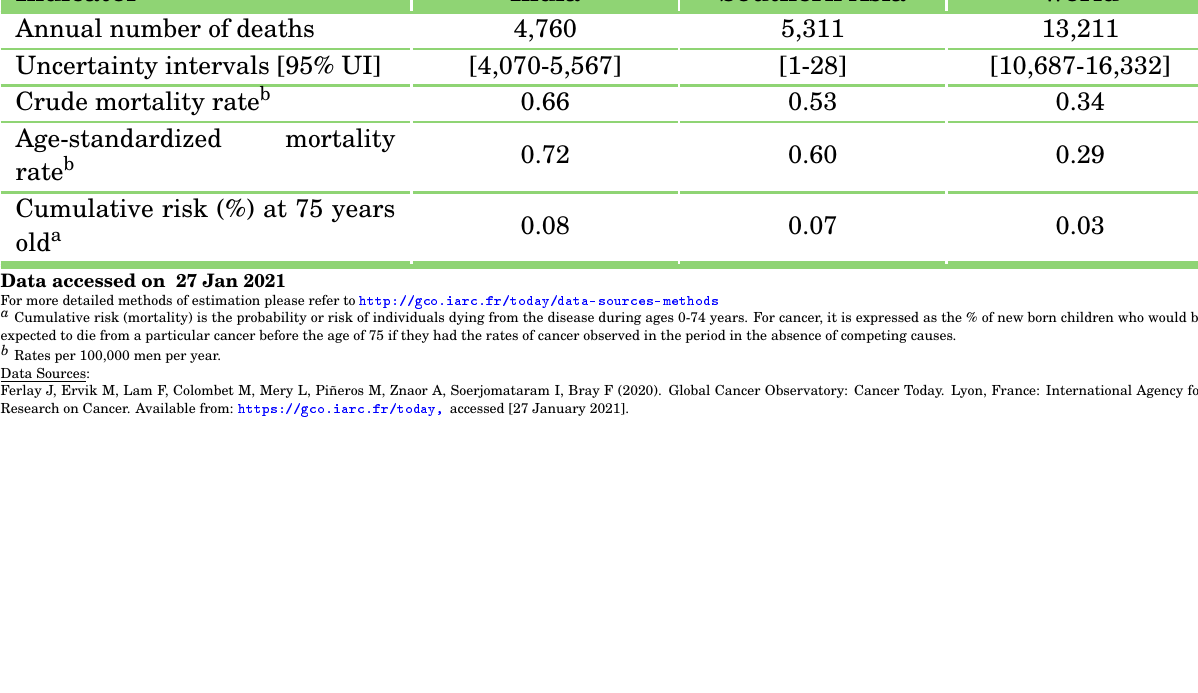
Table 14: Penile cancer mortality in India (estimates for 2020) Indicator India Annual number of